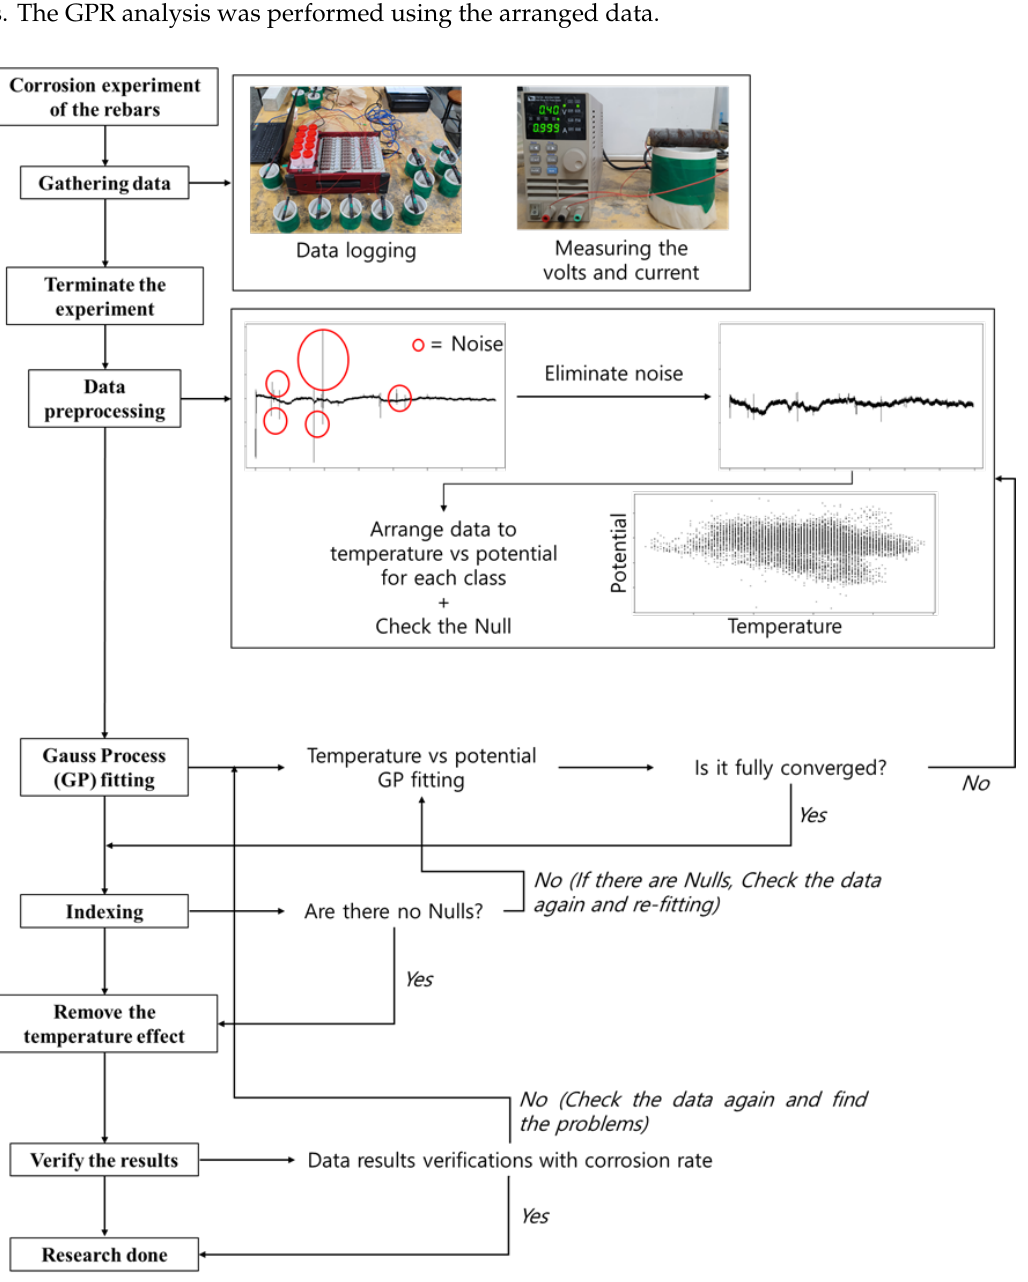
Figure 1. Research process of removing the temperature effect.